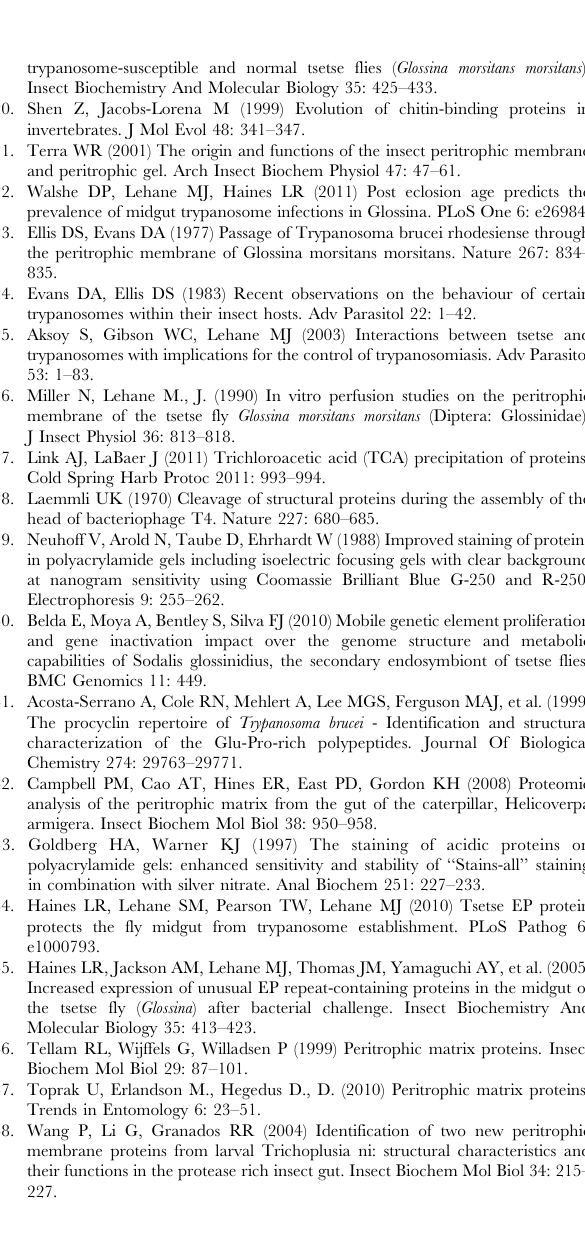
Table S1 List of Glossina morsitans morsitans peritrophic matrix proteins from in-gel digestion analysis (ion score cut off of 30). Table S2 List of Sodalis glossinidus proteins associated with the Glossina morsitans morsitans peritrophic matrix.